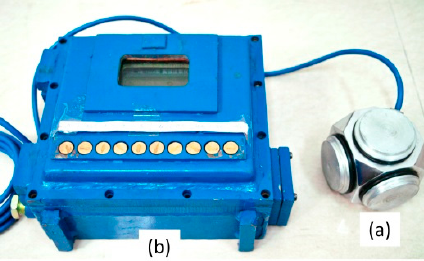
Figure 4. Explosion-proof data acquisition instrument (( a ). 3D comprehensive stress transducer; ( b ). data acquisition instrument).